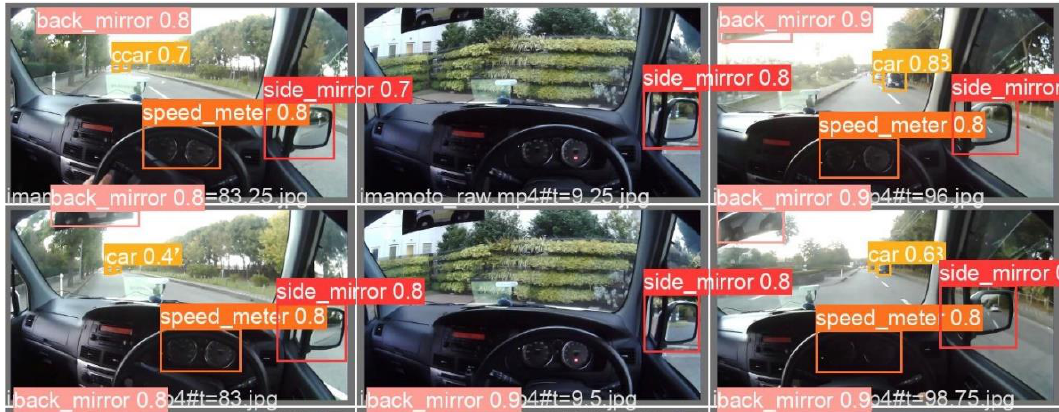
Figure 5. Example of object detection.